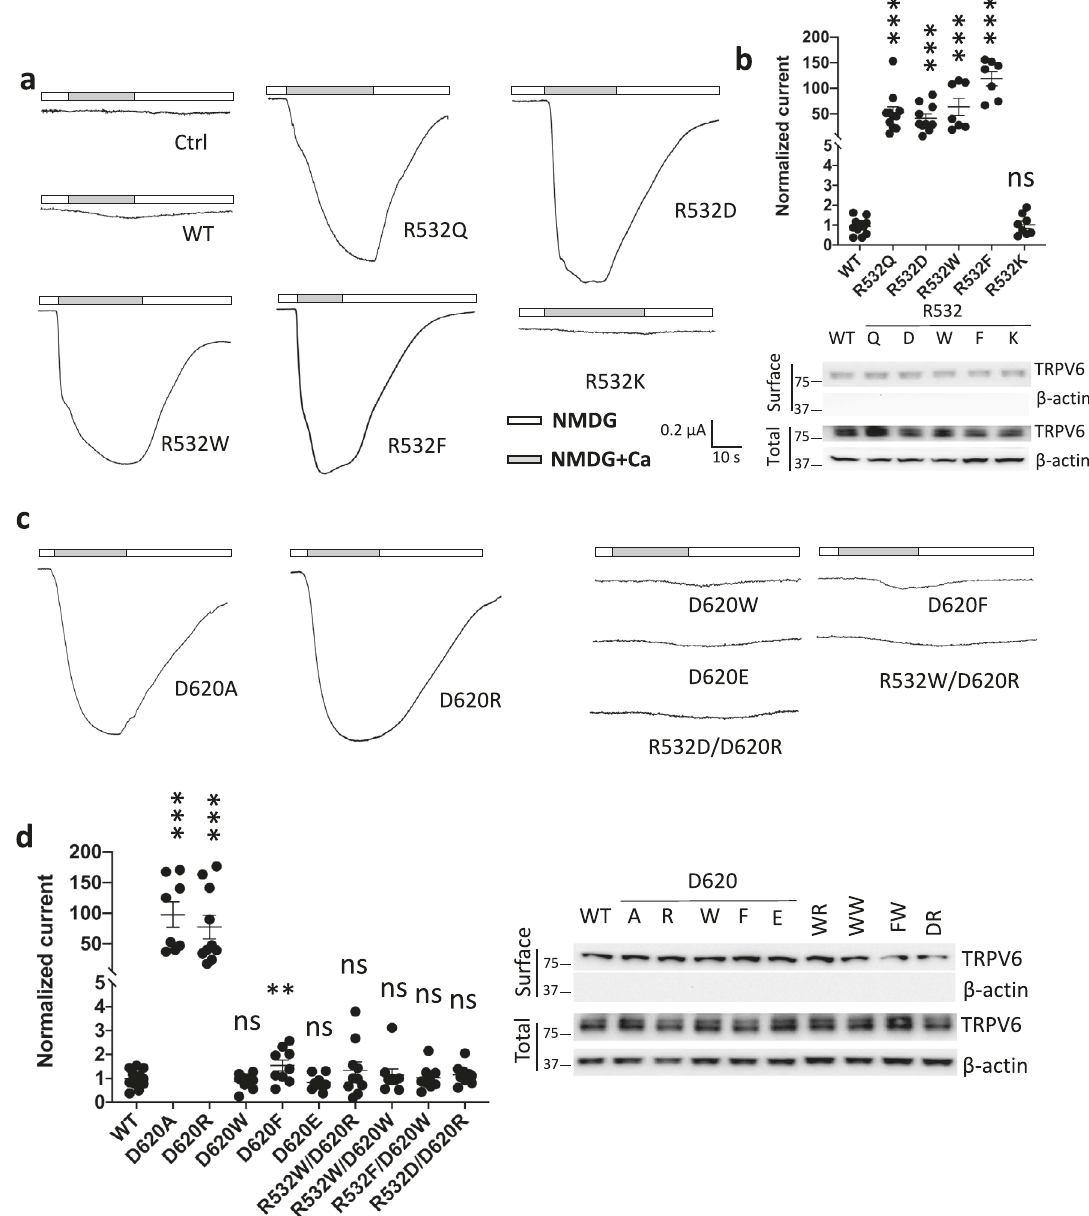
Fig. 1 Functional roles of the TRPV6 residues R532 and D620. a Representative current traces from water-injected (Ctrl) oocytes and those expressing WT TRPV6 or a R532 mutant. b Upper panel: averaged and normalized current values for WT TRPV6 WT or a R532 mutant expressed in oocytes. *** p < 0.001; ns not signi fi cant. Lower panel: total and surface expression of WT TRPV6 and R532 mutants revealed by biotinylation. β -actin acts as loading control. c Representative current traces from oocytes expressing different TRPV6 mutants. d Left panel: averaged and normalized current values corresponding to WT or mutant TRPV6. Right panel: total and surface expression of WT or mutant TRPV6. ** p < 0.01; *** p < 0.001; ns not signi fi cant, from three independent